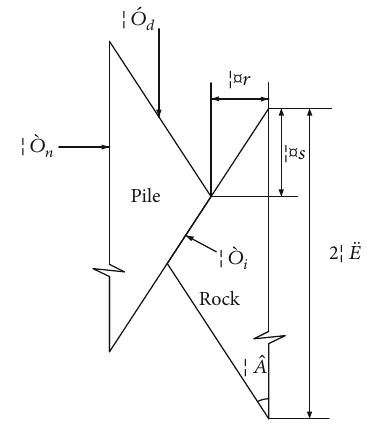
Figure 4: Schematic view of shear dilation for pile-rock interface.